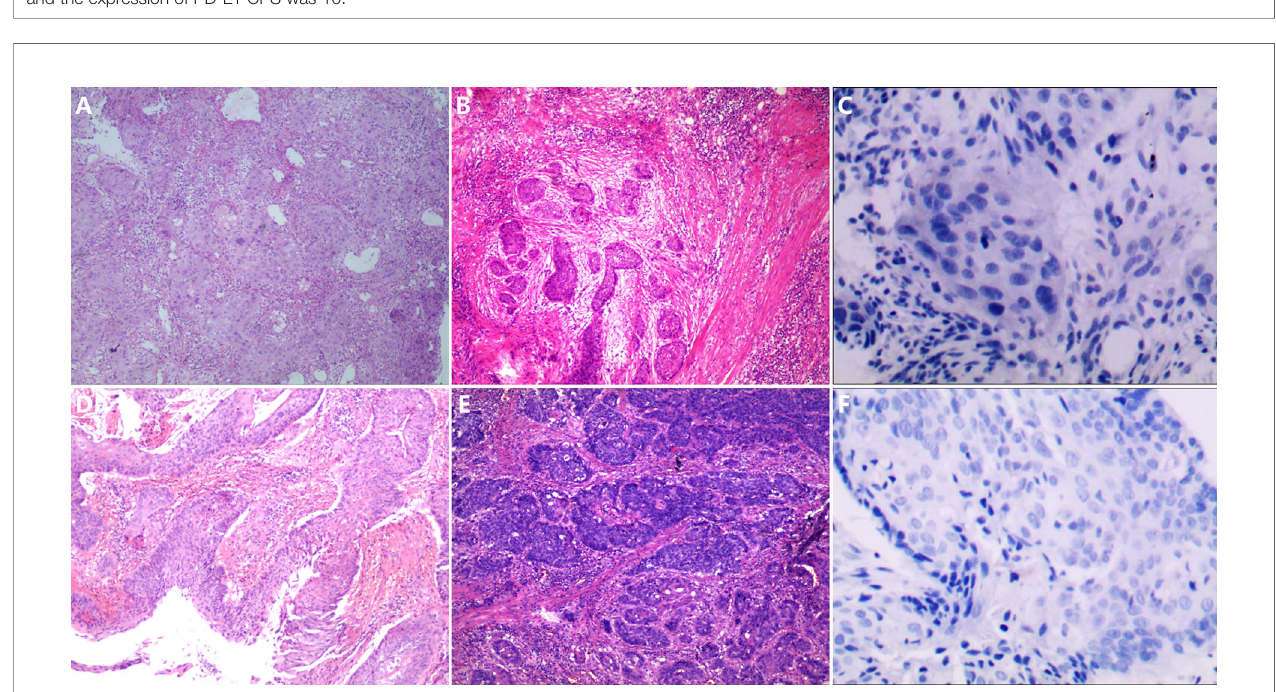
FIGURE 4 | The pathological changes before and after neoadjuvant chemoimmunotherapy and the PD-L1 expression. (A, B) The pathological changes in patient 7; after neoadjuvant chemoimmunotherapy, there are a large number of tumor cells left in the section, and a few lymphocytes in fi ltrated. (C) The expression of PD-L1 combined positive score (CPS) in the sample before therapy in patient 7, and the expression of PD-L1 CPS was lower than 1. (D, E) The pathological changes in patient 8; after neoadjuvant chemoimmunotherapy, there are a large number of tumor cells left in the section and few lymphocytes in fi ltrated. (F) The expression of PD-L1 CPS in the sample before therapy in patient 8, and the expression of PD-L1 CPS was lower than